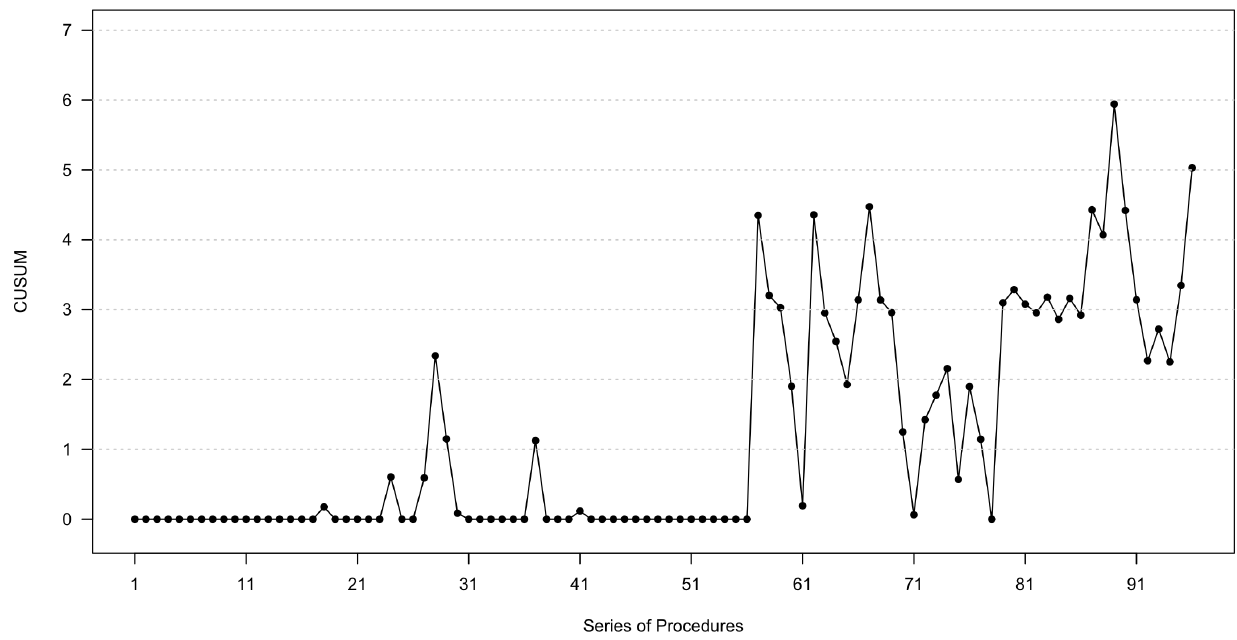
Figure 1. The upward CUSUM chart. The CUSUM curve tended to be flat until the 25th case. After the initial 25 cases, the curve showed a rising pattern but declined again. However, CUSUM curve showed an upward shift. After the 56th case, the change point analysis result presented the 56th case was the mean change point. As a result, the fragmentation efficacy reached a plateau from this point. doi:10.1371/journal.pone.0084878.g001 PLOS ONE |